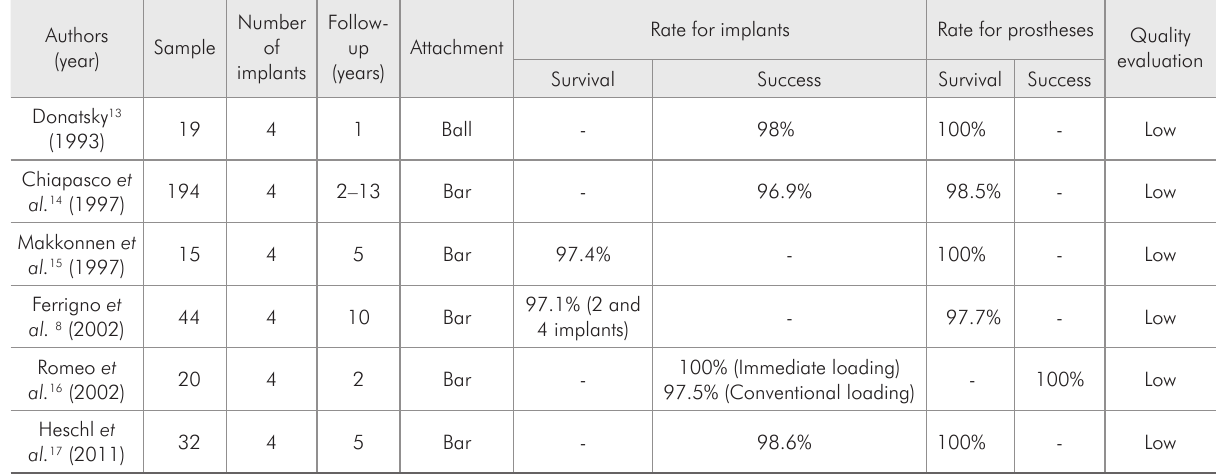
table 2 - Results of studies with four implants.